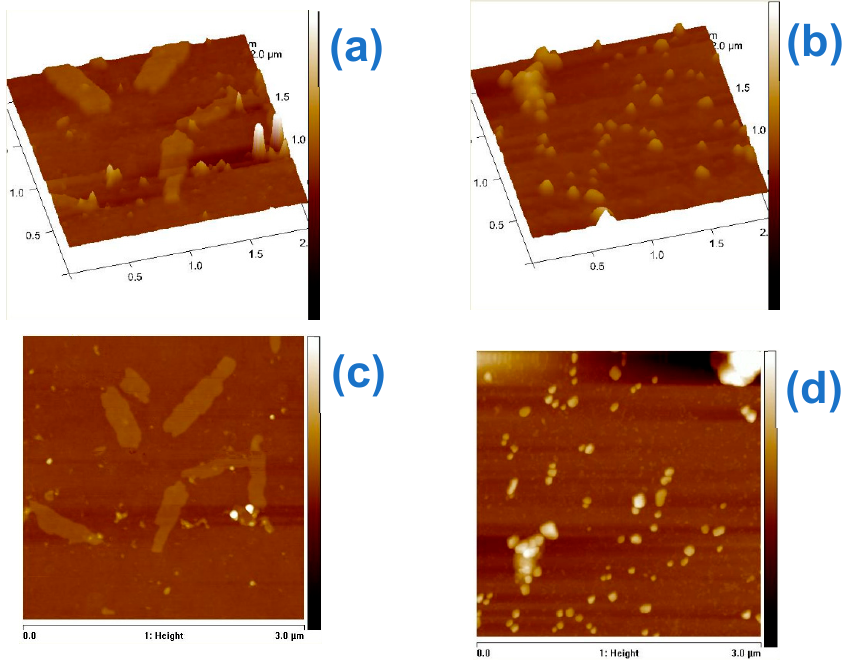
Figure 9. AFM images of control E. coli samples ( a ) 3D and ( c ) 2D-height; and E. coli cells after 20 min of exposure to Cu@TFSA ( b ) 3D and ( d ) 2D-height.